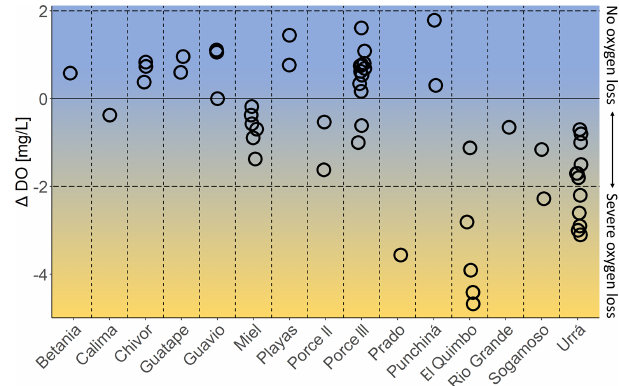
Figure 3. The temperature differences between the upstream and downstream river surfaces of 15 hydropower dams in Colombia. Each point represents one pair of contemporaneous measurements from the most recent year of available data (either 2018 or 2017).